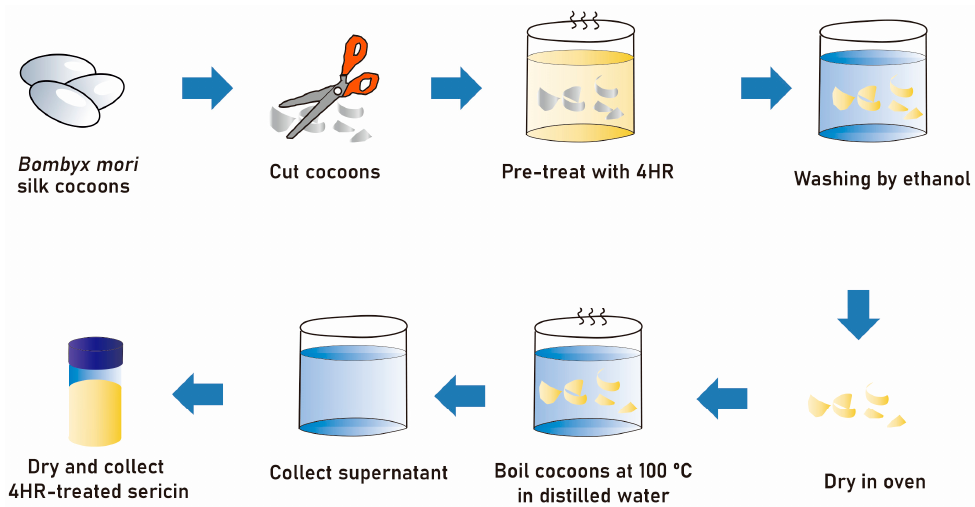
Figure 6. Schematic drawing of the method used for 4HR pretreatment of silk cocoons and subsequent extraction of silk sericin.